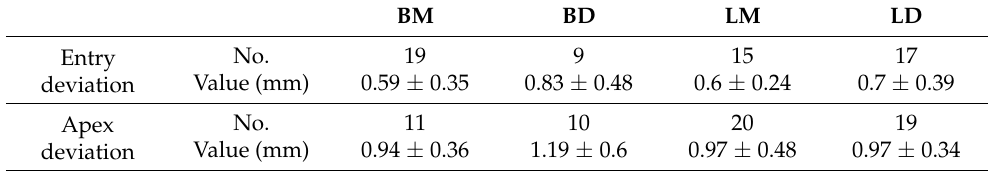
Table 2. Directions of horizontal deviation of the implant position obtained by the DNS-based method.